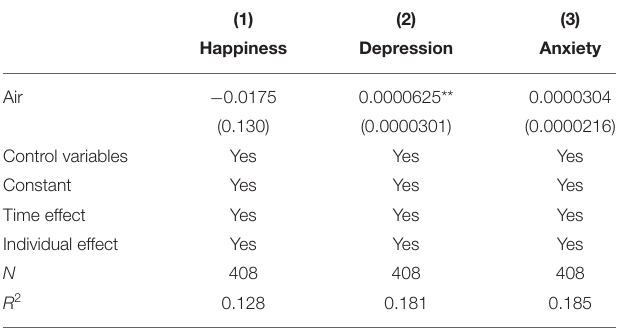
TABLE 7 | Robustness test result of replacing estimation